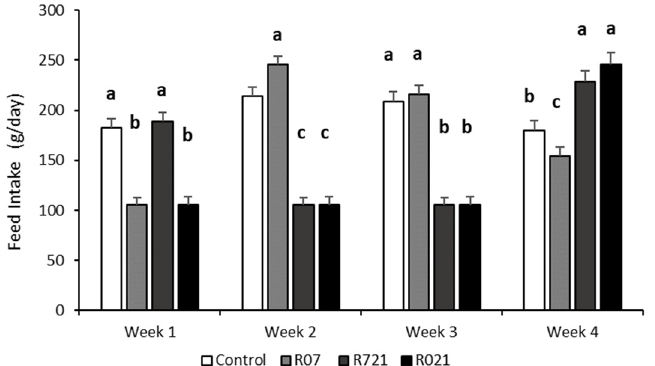
Figure 2. Weekly evolution of the daily feed intake (g/day) in pregnant rabbit does fed ad libitum (Control), restricted to 60% one week from day 0 to 7 (R07), two weeks from day 7 to 21 (R721) and three weeks from day 0 to 21 (R021) of gestation. (a–c): Different letters represent significant differences between experimental groups ( p < 0.0001).